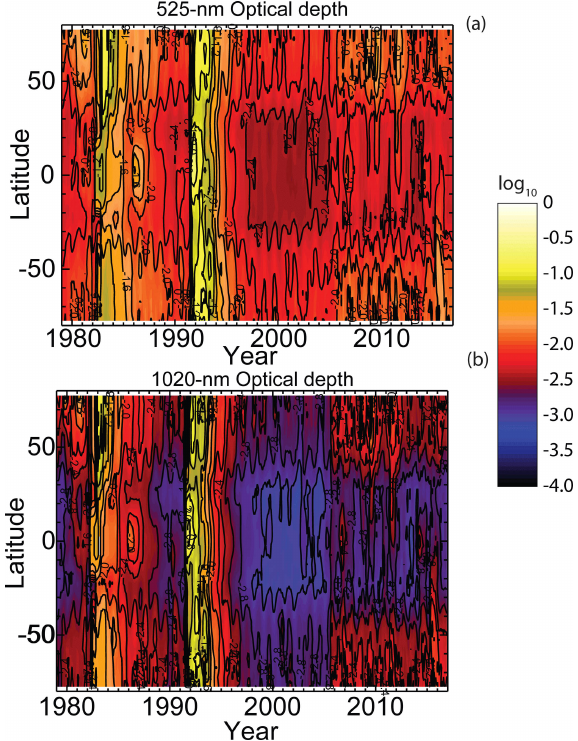
Figure 16. Total GloSSAC stratospheric aerosol optical depth at 525 (a) and 1020nm (b) . We show contours at 0.0006, 0.0008, 0.001, 0.002, 0.004, 0.006, 0.008, 0.01, 0.02, 0.04, 0.06, 0.08, 0.1, 0.15, 0.2, and